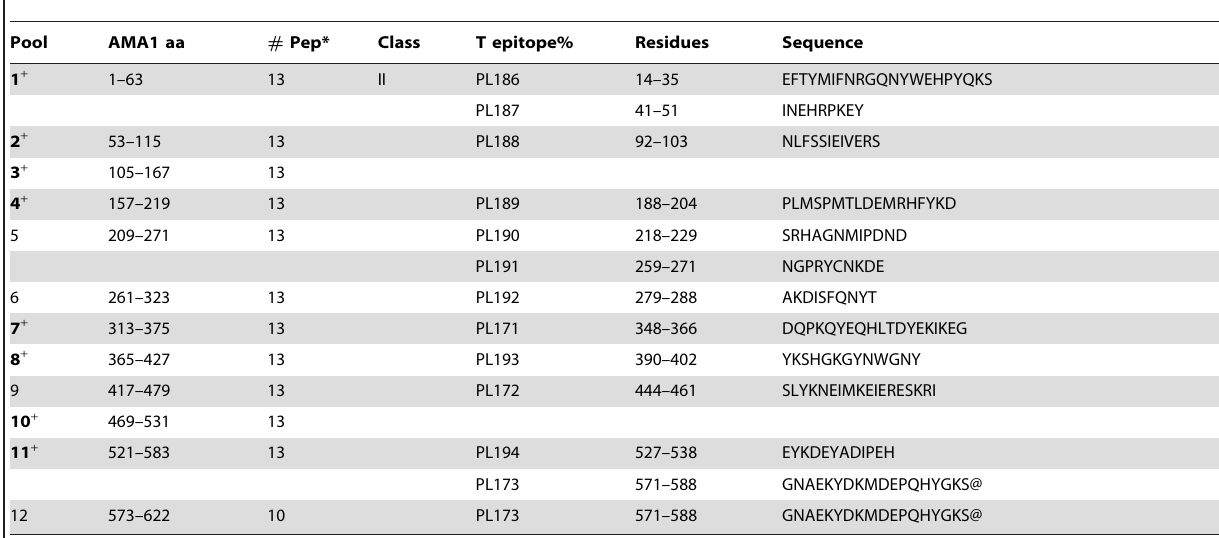
Table 3. AMA1 peptides used in ELISpot and ICS